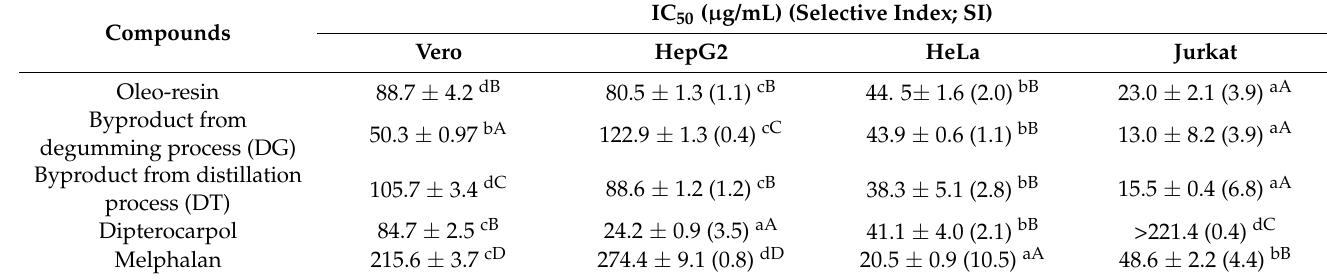
Table 4. Cytotoxic activity and selectivity index (SI) values of oleo-resin, resin from different prepara- tion processes and dipterocarpol against cancer cells HepG2, HeLa, Jurkat, and in noncancerous Vero cells after 2 h exposure.